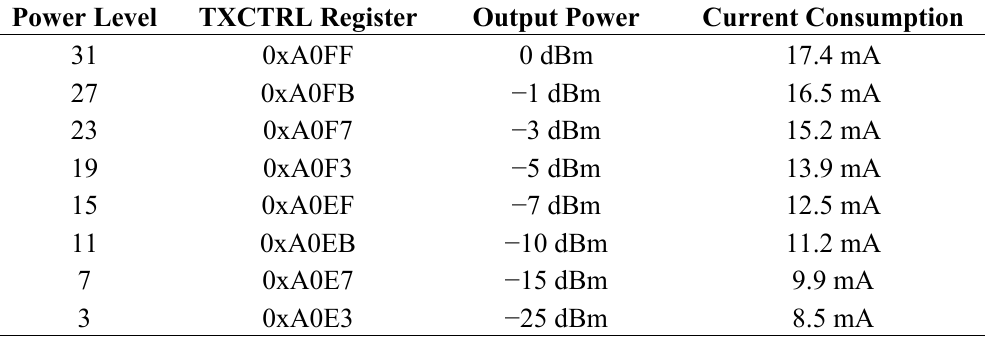
Table 1. CC2420 TXCTRL